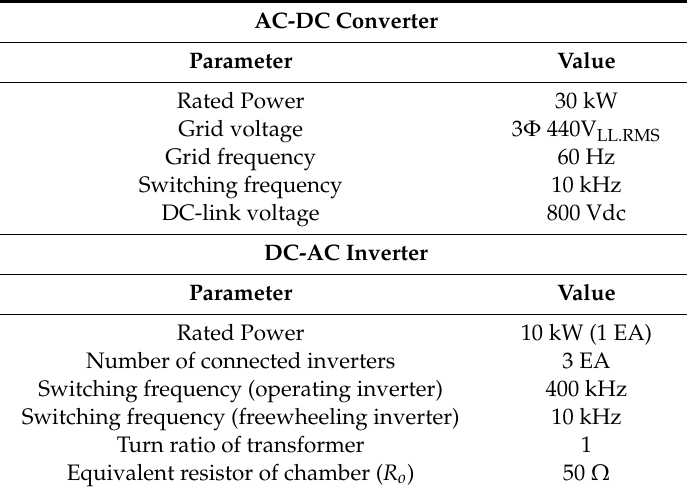
Table 1. Specifications of the power conversion system (PCS) for plasma generators.